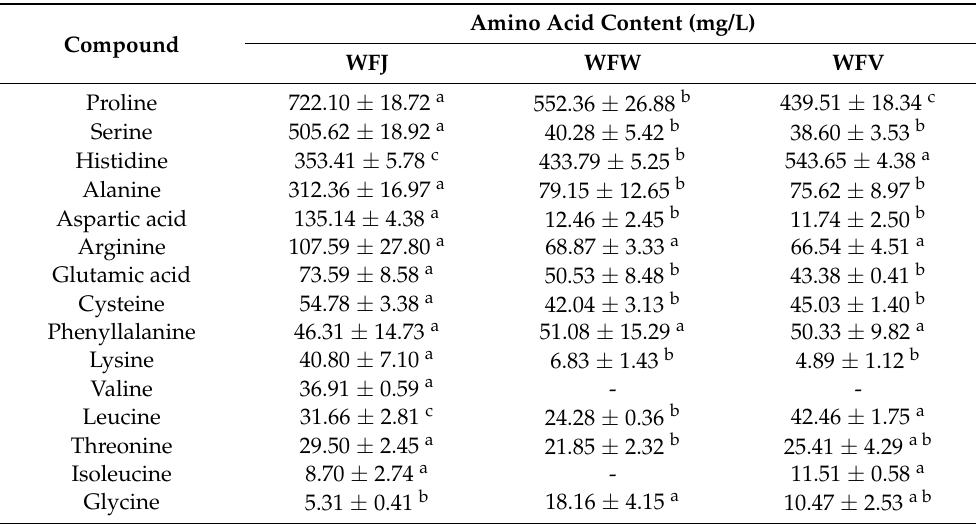
Table 3. Types and contents of amino acids in wolfberry fruit vinegar in the fermentation